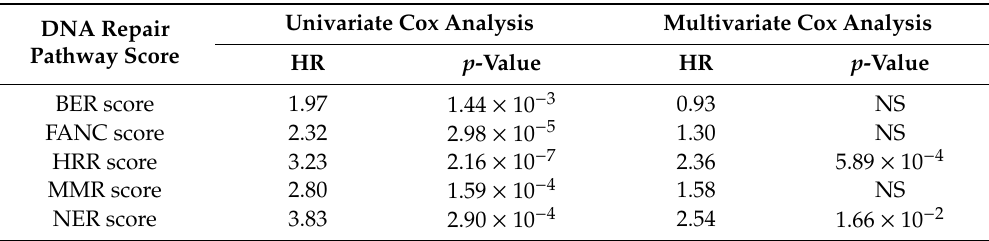
Table 2. Cox analysis of overall survival in CN-AML training cohort ( n = 162) according to DNA repair pathway scores. Hazard ratio (HR) and p-values are shown for each DNA repair pathway score in univariate and multivariate Cox analysis. NS: not